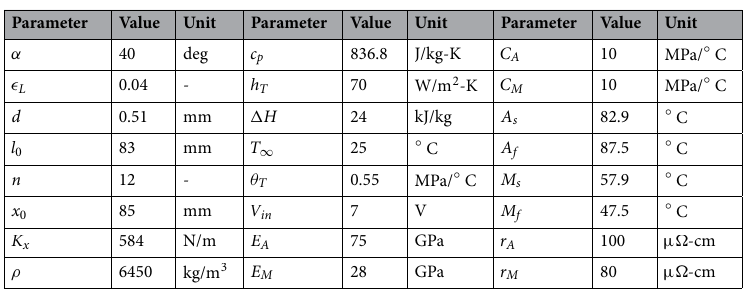
Table 1. The list of parameters and values used for analytical modelling. The A and M subscripts in the parameters modulus of elasticity ( E ), slope ( C ), and resistivity ( r ) represent the austenite and martensite phase values, respectively. The s and f subscripts for the austenite and martensite transition temperatures denote the beginning and end of the transition temperature, respectively. Additionally, the material properties such as the density of the wire ( ρ ), specific heat of the wire ( c p ), latent heat of the SMA ( (cid:31) H ), thermal expansion factor ( θ T ) have been listed in this table. Furthermore, the angle of pennation ( α ), maximum transformation strain ( ǫ L ), diameter of the wire ( d ), initial length of the SMA wire in each unipennate branch ( l 0 ), number of unipennate branches ( n ), and the bias spring constant ( K x ) have been listed as values of parameters deployed in the design. As for the input conditions of the setup, initial spring deformation ( x 0 ), convective heat transfer co-efficient ( h T ), ambient temperature ( T ∞ ) and input voltage ( V in ) have also been mentioned in the